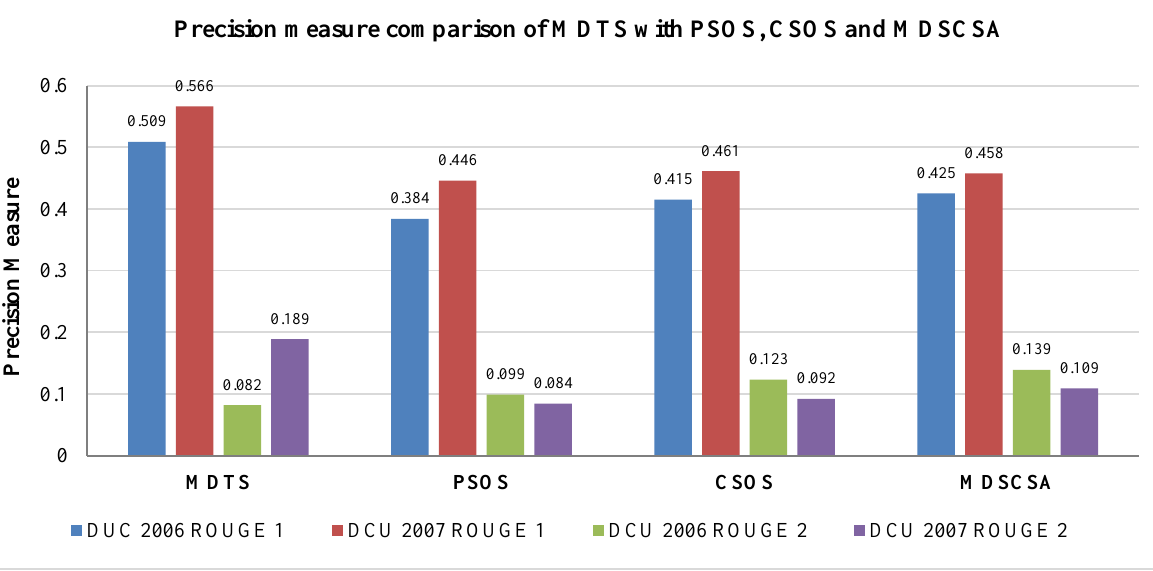
Figure 3. Comparison of Precision measure of MDTS with PSOS, CSOS and MDSCSA for DUC 2006, DUC 2007